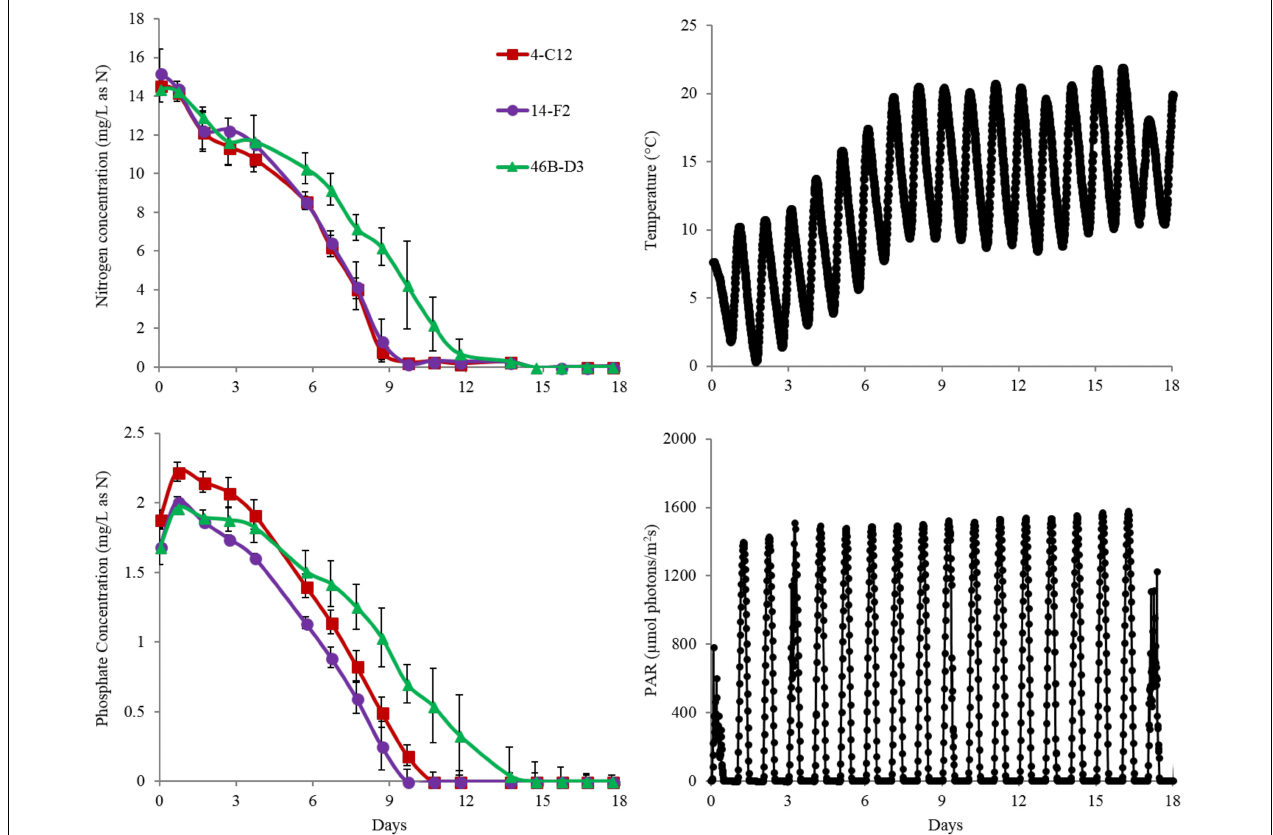
FIGURE 3 | Nitrogen (as ammonium) depletion of strains grown outdoors during the winter month of February 2016 (1st–19th) (Top Left). Phosphate depletion of strains grown outdoors under winter conditions (Bottom Left). Representative change in temperature of ponds throughout the experiment (Top Right). Representative change in PAR of ponds throughout the experiment (Bottom Right). Average and standard deviation error bars are from 3 biological